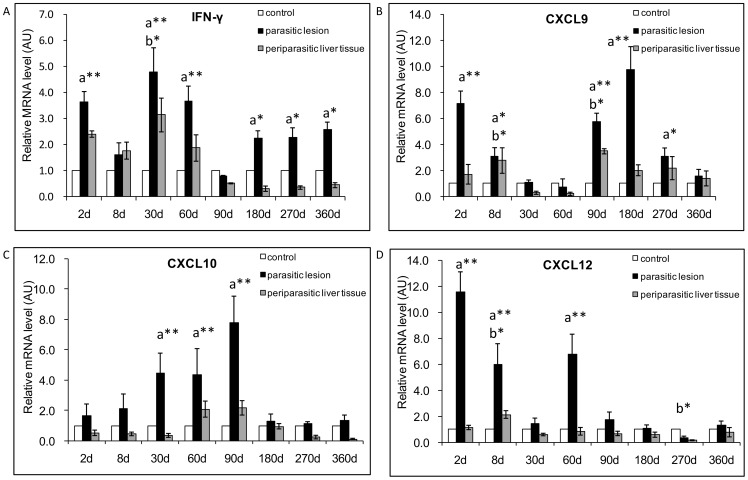
Course of Th1-cytokine and related chemokine gene expression in the liver of mice during E. multilocularis infection (measured by qRT-PCR).(A) IFN-γ, (B) CXCL9, (C) CXCL10, (D) CXCL12. a: ‘Parasitic lesion’ versus ‘Control’; b: ‘Periparasitic liver tissue’ versus ‘Control’. *P<0.05; **P<0.01. ‘Control’, non-infected mice; ‘Parasitic lesion’: E. multilocularis metacestode and surrounding immune infiltrate; ‘Periparasitic liver tissue: liver parenchyma close to the E. multilocularis lesion, but excluding macroscopically visible liver tissue alterations. AU: arbitrary units.